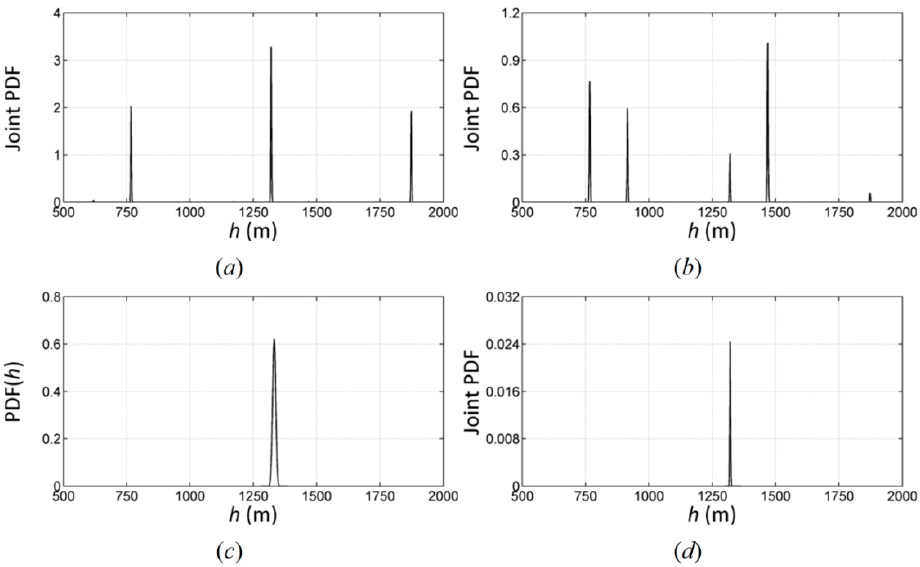
Figure 12. The height probability distribution of a cell in the simulated interferogram with a true height of h = 1320.4 m. ( a , b ) The joint height probability distribution with and without decorrelation phase noise, respectively; ( c ) the prior height probability distribution acquired from the prior DEM; ( d ) the joint height probability distribution with the prior height probability distribution, obtained by multiplying the two probability distributions in ( b , c ).